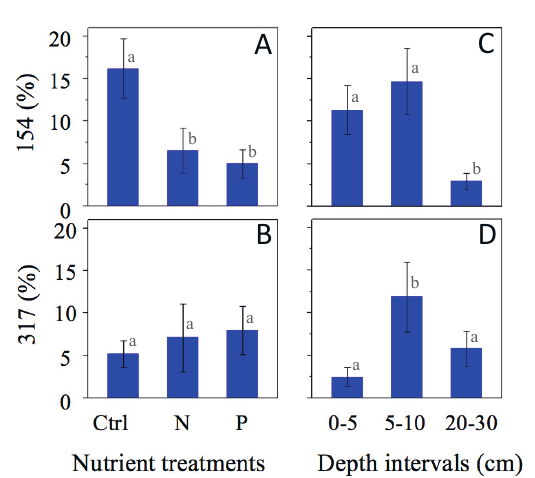
Figure 3. Relative abundance (%) of the most abundant TRFLP-OTUs among the fertilization treatments ( A , B ) and sediment depth intervals ( C , D ). Data shown as Avg. ± SE ( n ≥ 3). Bars with the same lowercase letter are not significantly different at p < 0.05.